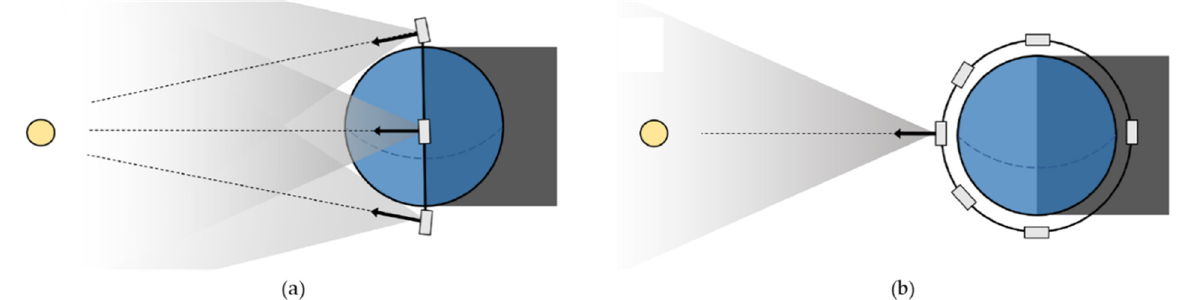
Figure 4. Sun Synchronous Orbit Comparison. ( a ) In a dawn/dusk orientation, the satellite maintains near-constant access to the Sun. Note that the tilt of the satellite at the extreme north and south points on the orbit in this diagram is greatly exaggerated. ( b ) In a noon/midnight orbit the satellite spends minimal time in Sun, with almost half of the orbit in eclipse. The arrows indicate antenna boresight.